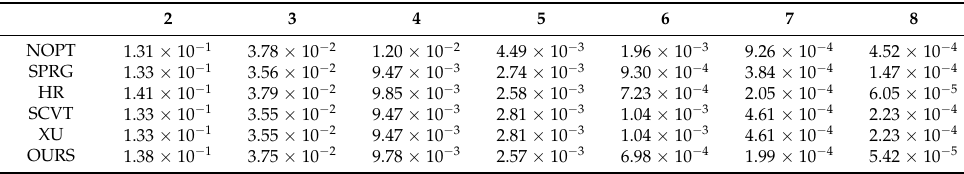
Table 11. L 2 -norm error of Laplacian operator of different